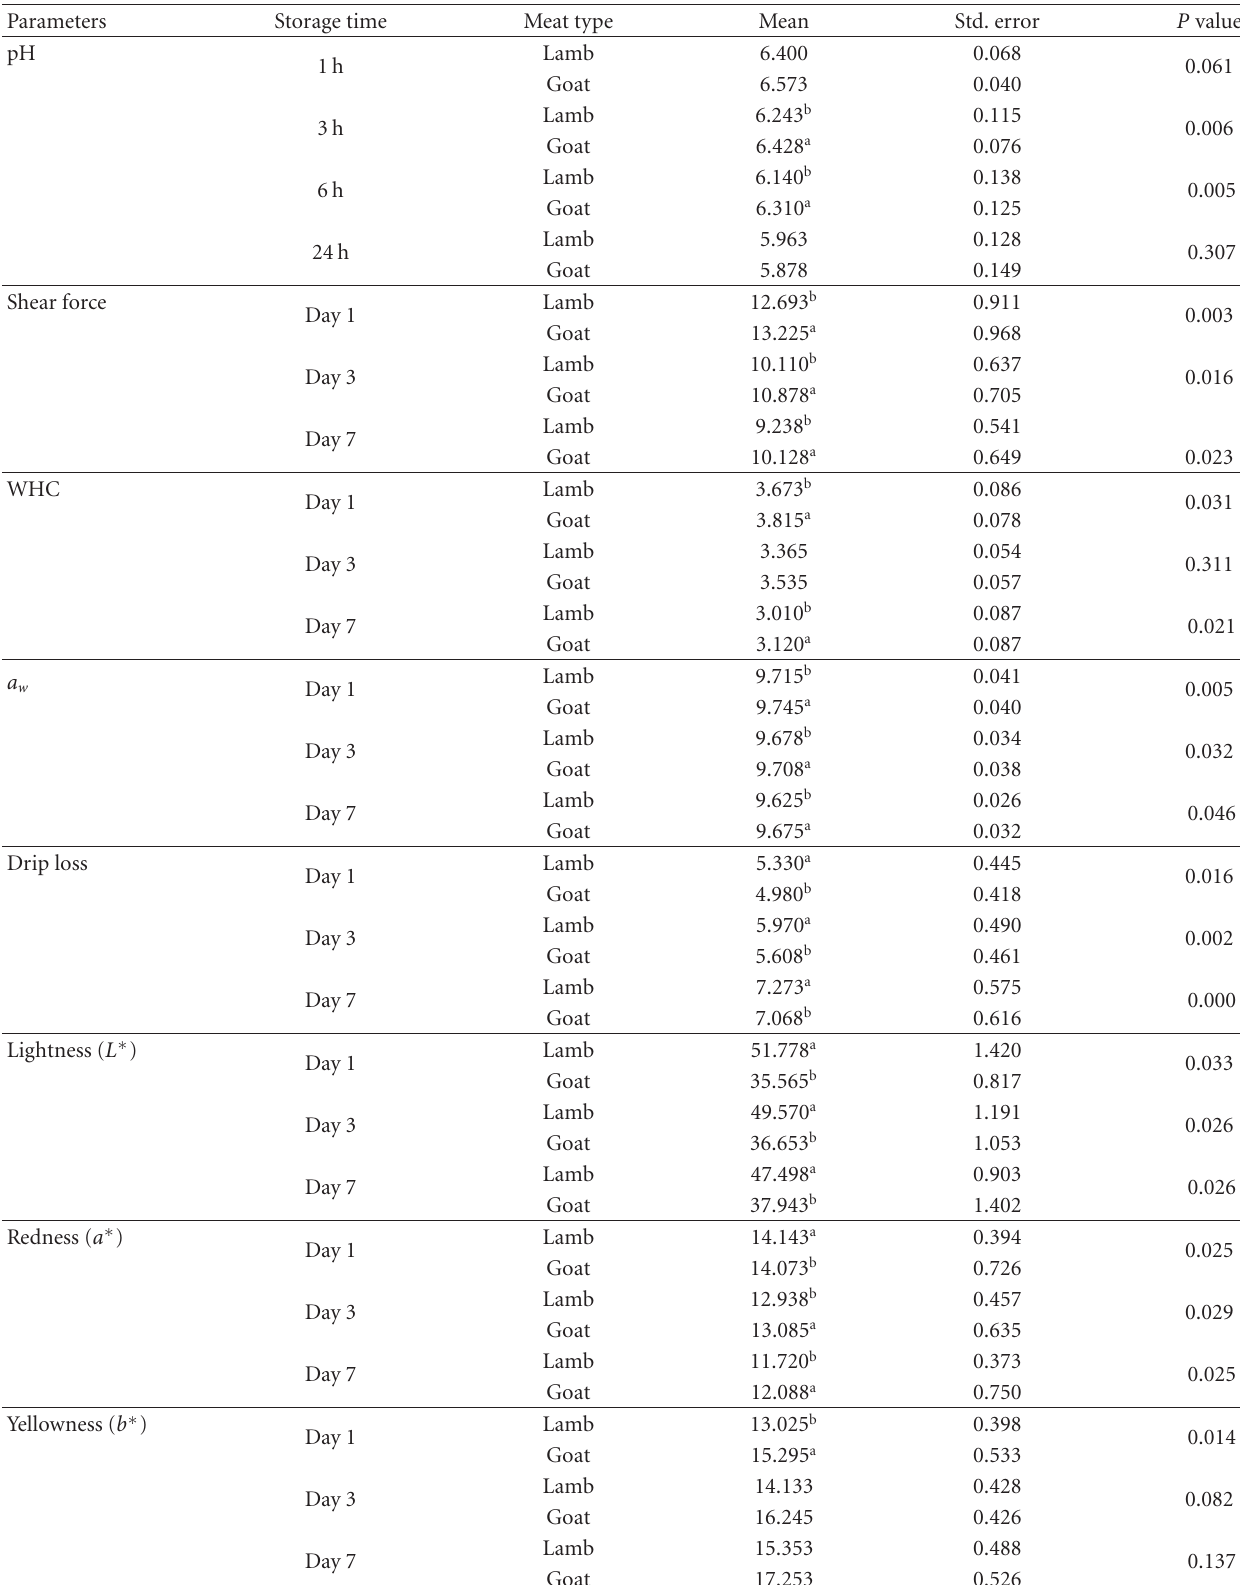
Table 6: Functional parameters variation in lamb and goat meat during aging at 4 ◦